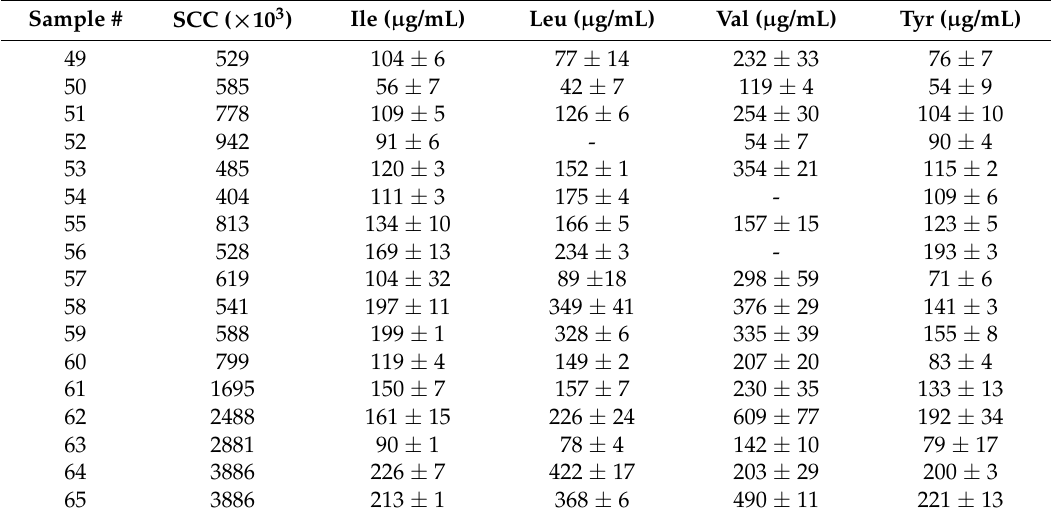
Table 2. Content values of selected amino acids in Group II, along with SCC